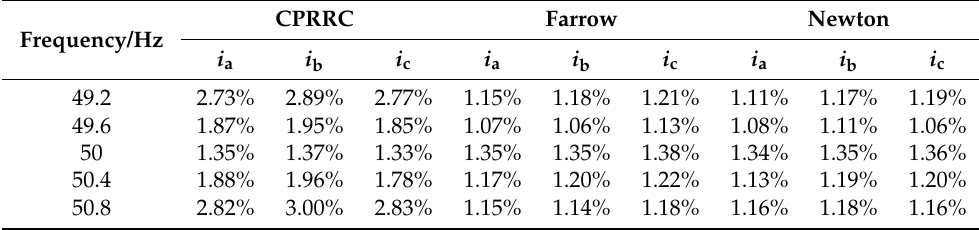
Table 2. The THD of grid ‐ current i g with different grid frequencies.